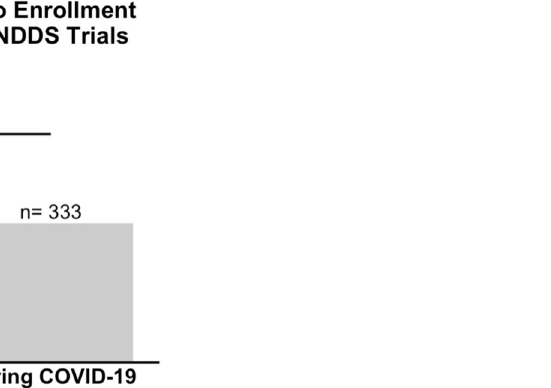
Fig 2. The rate of consent to enrollment into the NO/AKI and MINDDS trials dropped significantly during COVID-19. The rate of consent to enrollment among approached eligible patients was 64% (n = 1,001) in the “Before COVID-19” group and 45% (n = 333) in the “During COVID-19” group. Statistical analysis revealed a statistically significant difference in enrollment inquiry responses between the two time frames (n = 1,334, P < 0.001) and a difference in proportions of 19% (95% CI 12.88% to